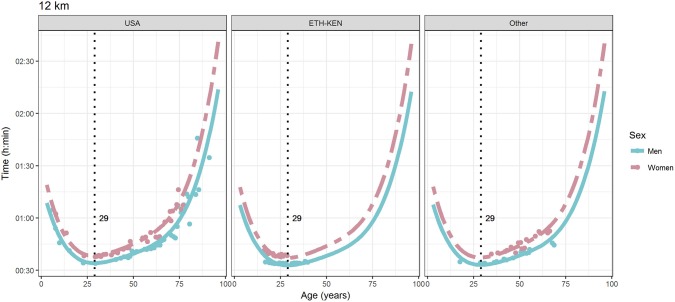
World record in 12 km by sex, age (in years), and country. Points were observations. Curves represented quartic degree polynomial regression. Vertical line with numeric label was the age at peak performance.